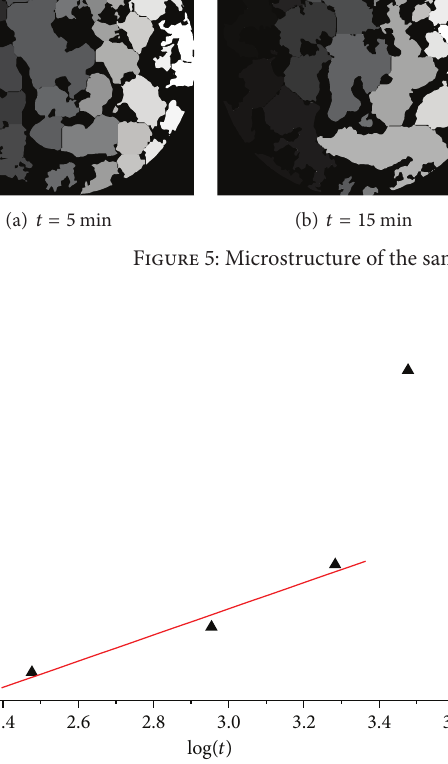
Figure 6: Double logarithm curve of mean neck size versus